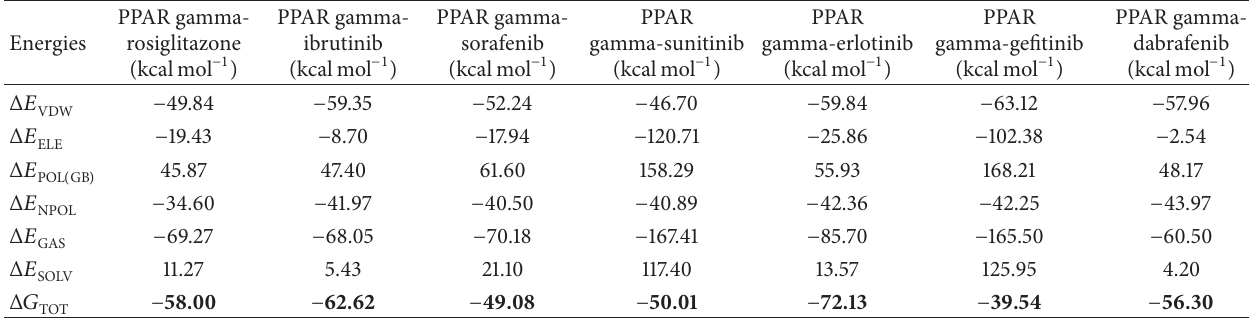
Table 3: Calculated total binding energies for PPAR gamma-TKI’s and PPAR gamma-rosiglitazone complexes by MM-PBSA. PPAR gamma- Energies